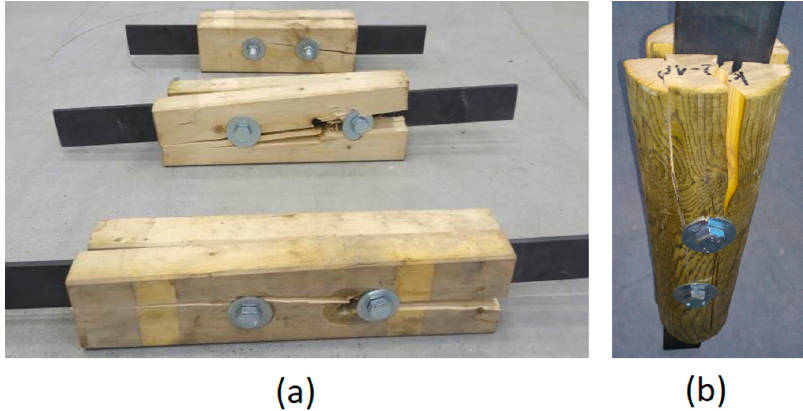
Figure 8. Specimens after failure: ( a ) Squared timber; ( b ) Round timber.